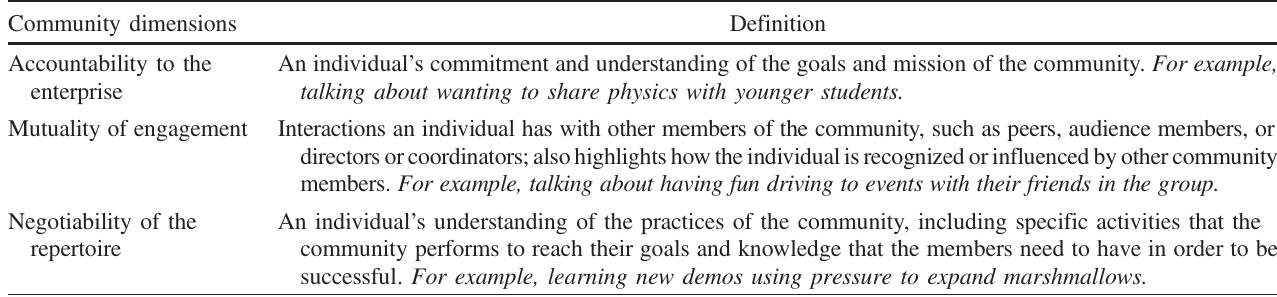
TABLE I. The three community dimension constructs with definitions and examples from the communities of practice framework. Community